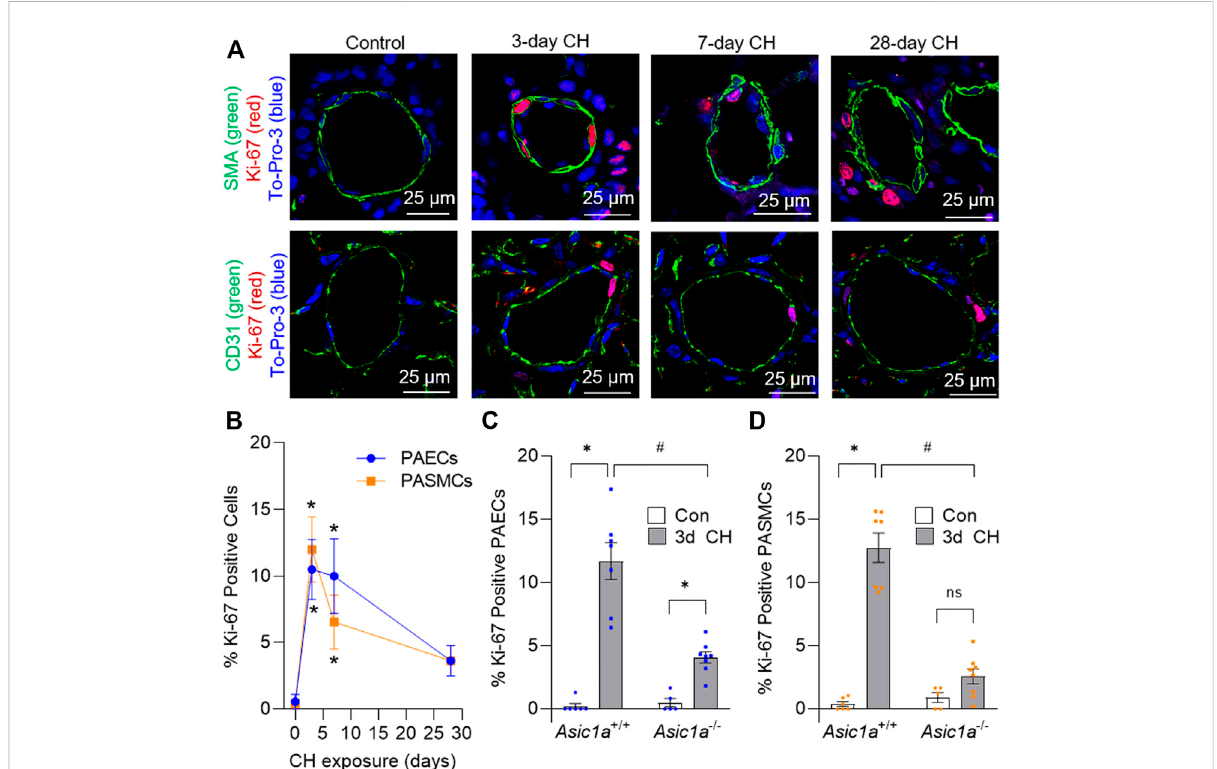
FIGURE 1 CH-induced proliferation of vascular cells is ASIC1a dependent. (A) Representative immuno fl uorescence images showing Ki-67 (red), α -SMA (green, top row), CD31 (green, bottom row), and To-Pro-3 (blue) in small pulmonary arteries ( < 100 µm) from Asic1a +/+ mice and (B) summary data showing the percent Ki-67 positive pulmonary arterial endothelial cells (PAECs, blue circles) and pulmonary arterial smooth muscle cells (PASMCs, orange squares) under control conditions or following exposure to CH(3-, 7-, or 28-days). n = 3 animals per group (~20 vesselswereaveraged for each animal); analyzed as one-way ANOVA for each cell type and individual groups compared with Š ídák ’ s multiple comparisons tests. Summary data showing percent Ki-67 positive (C) PAECs and (D) PASMCs in small pulmonary arteries ( < 100 µm) from Asic1a +/+ and Asic1a − /- mice under control conditions or following 3-days CH exposure. n = fi ve to eight animals (~15 vessels were averaged for each animal); analyzed by two-way ANOVA. Signi fi cant interactions between the individual groups ( p < 0.0001 for both PAECs and PASMCs) were compared with Š ídák ’ s